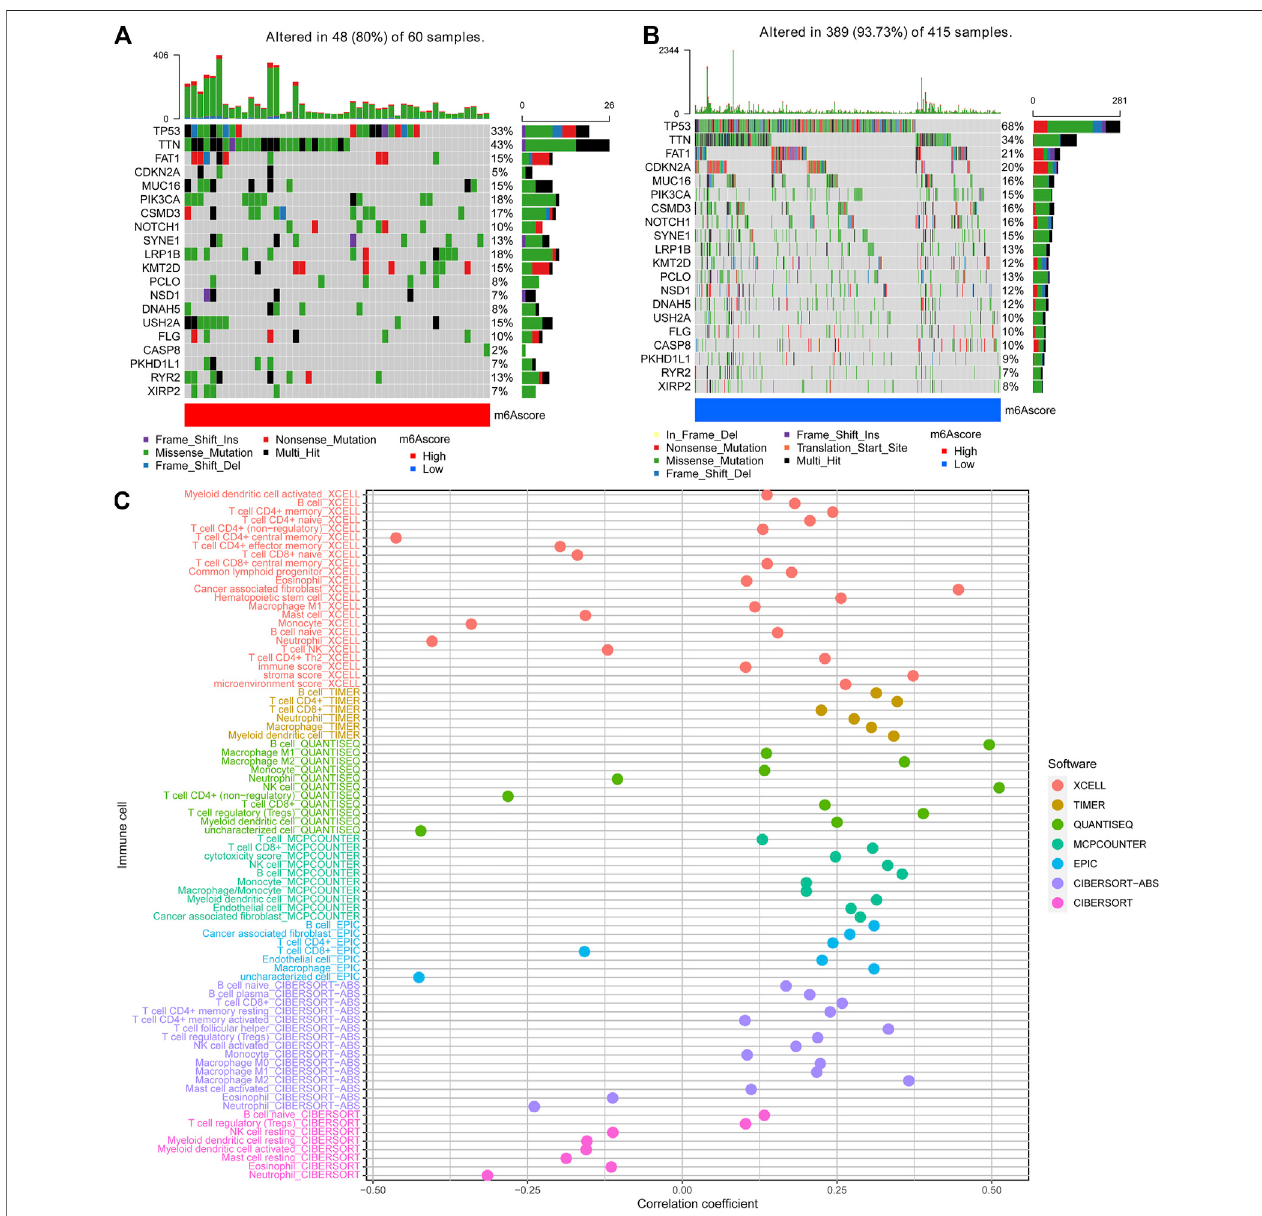
FIGURE5| CharacteristicsofthePyroptosisScoresignatures. (A) .Distributionofsomaticmutationsinthehigh-PyroptosisScoregroup. (B) .Distributionofsomatic mutations in the low-PyroptosisScore group. (C) . Detailed Spearman correlation analysis performed using different algorithms.